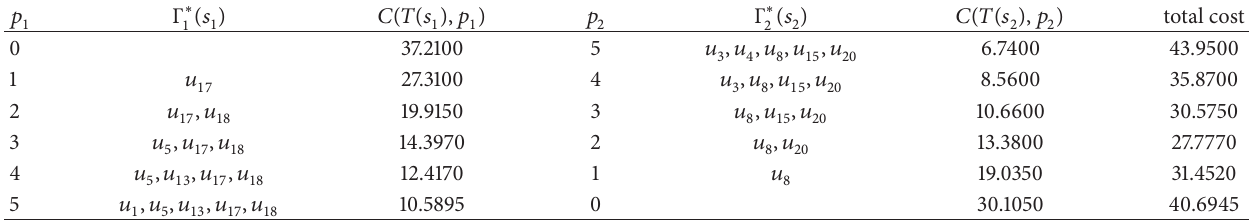
Table 2: Major data output by GLOB for (5, 2) -CSOP CLP on 𝑇